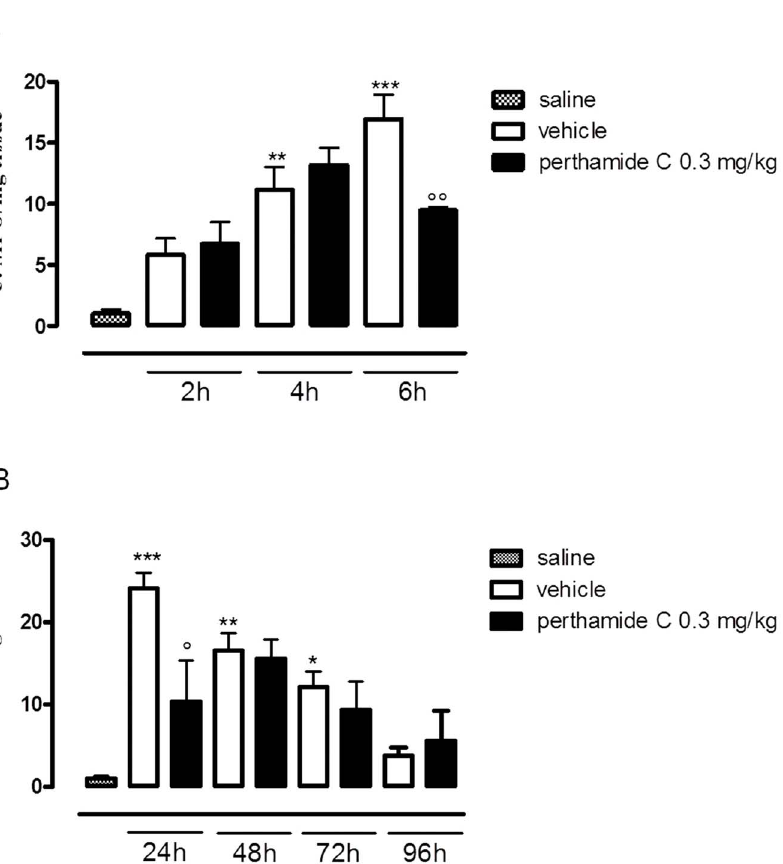
Figure 1. Perthamide C reduces MPO activity in both phases of oedema. Paws were harvested at different time points 2-4-6 h (A) and 24-48- 72-96 h (B) from each group of animals and processed in order to measure MPO activity. Values are expressed as mean 6 s.e.m. ( n =4–6 paws for each time point). * P , 0.05 ** P , 0.01, *** P , 0.001 vs S (saline), u P , 0.05, uu P , 0.01 vs vehicle.